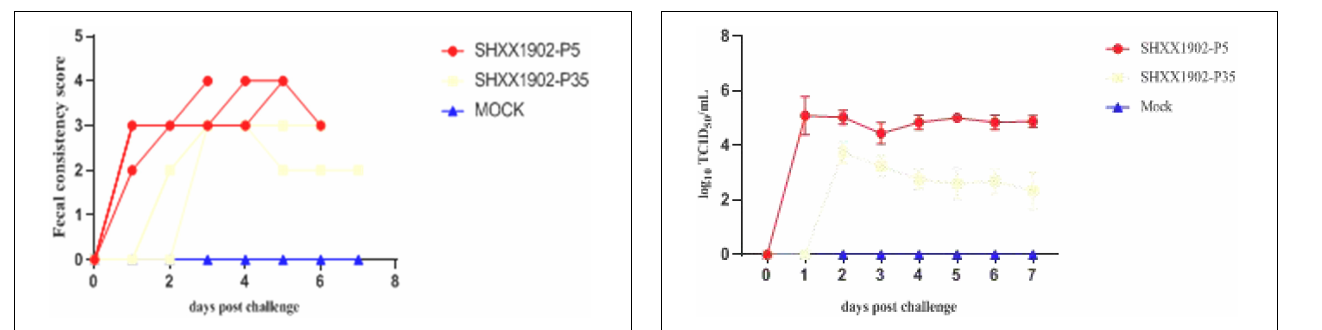
into the intestinal cavity to form more intestinal villus structures (blue arrow); the intestinal villi were underdeveloped, differed in height, and were fat or thin, and the mucosal epithelium was complete. Some capillaries in the lamina propria were slightly congested (green arrow), and a small amount of lymphocyte infiltration was seen on top of a small number of intestinal villi (yellow arrow); the glands in the lamina propria were evenly distributed and closely arranged, and Pan’s cells at the bottom had disappeared (red arrow). SHXX1902-P5: The